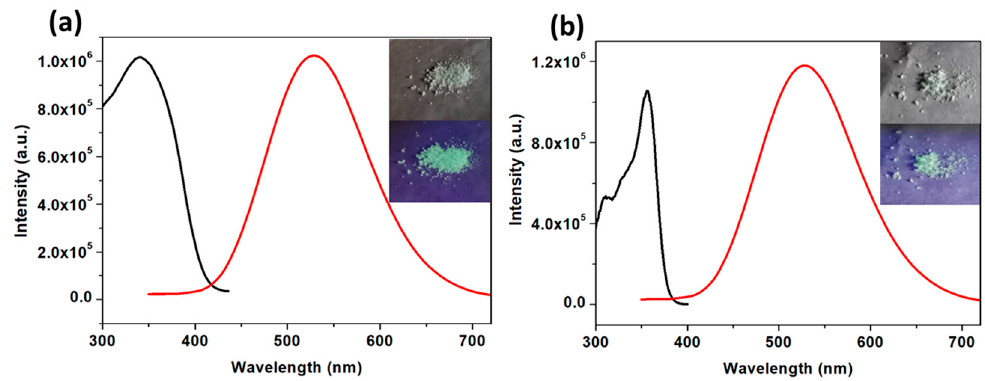
Figure 7. Emission spectra plots (red) and excitation spectra plots of 1 ( a ) and 2 ( b ). λ ex = 320 nm, λ em = 525 nm. Inset: sample under natural light and UV light.